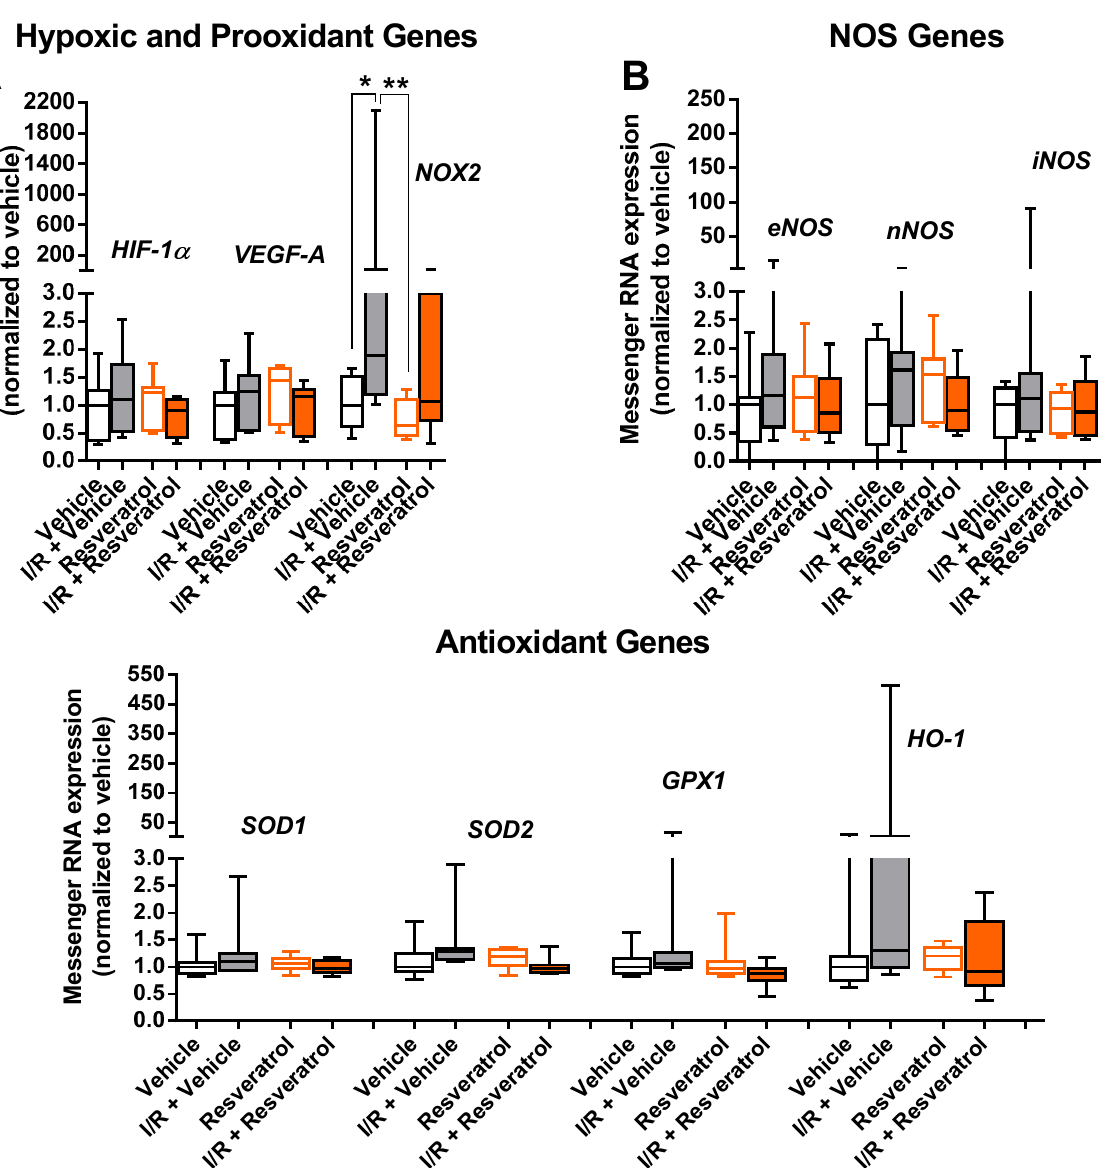
Figure 5. Messenger RNA expression for the hypoxic markers, HIF-1 α and VEGF-A ( A ), the prooxidant enzyme, NOX2 ( A ), the three NOS isoforms, eNOS, nNOS and iNOS ( B ), and for the antioxidant enzymes, SOD1, SOD2, GPX1 and HO-1) ( C ). In eyes treated with vehicle only, I/R induced upregulation of NOX2 expression, which was not observed in resveratrol-treated eyes. Data are presented as boxplots with minimum and maximum values (** p < 0.01; * p < 0.05; n = 8 per